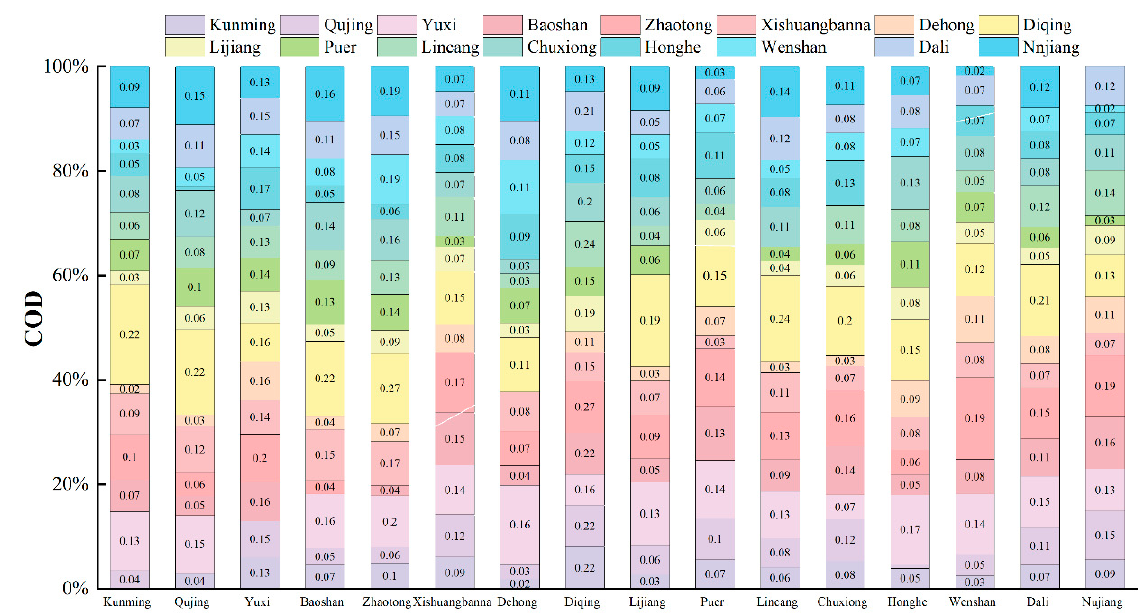
Figure 3. The average spatial distribution of O 3 -8h, NO 2 and CO in Yunnan Plateau from 2015 to